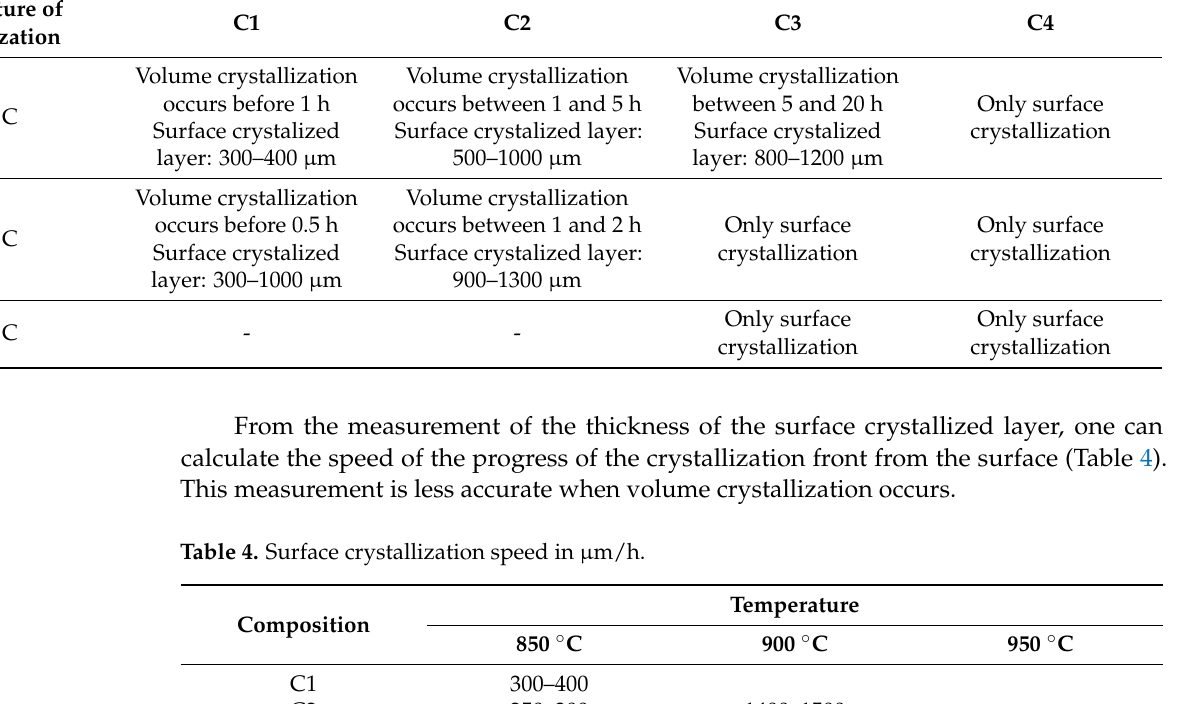
Table 3. Summary of the results of the thermal treatments for the four compositions from the point of view of the competition between surface and volume crystallization.